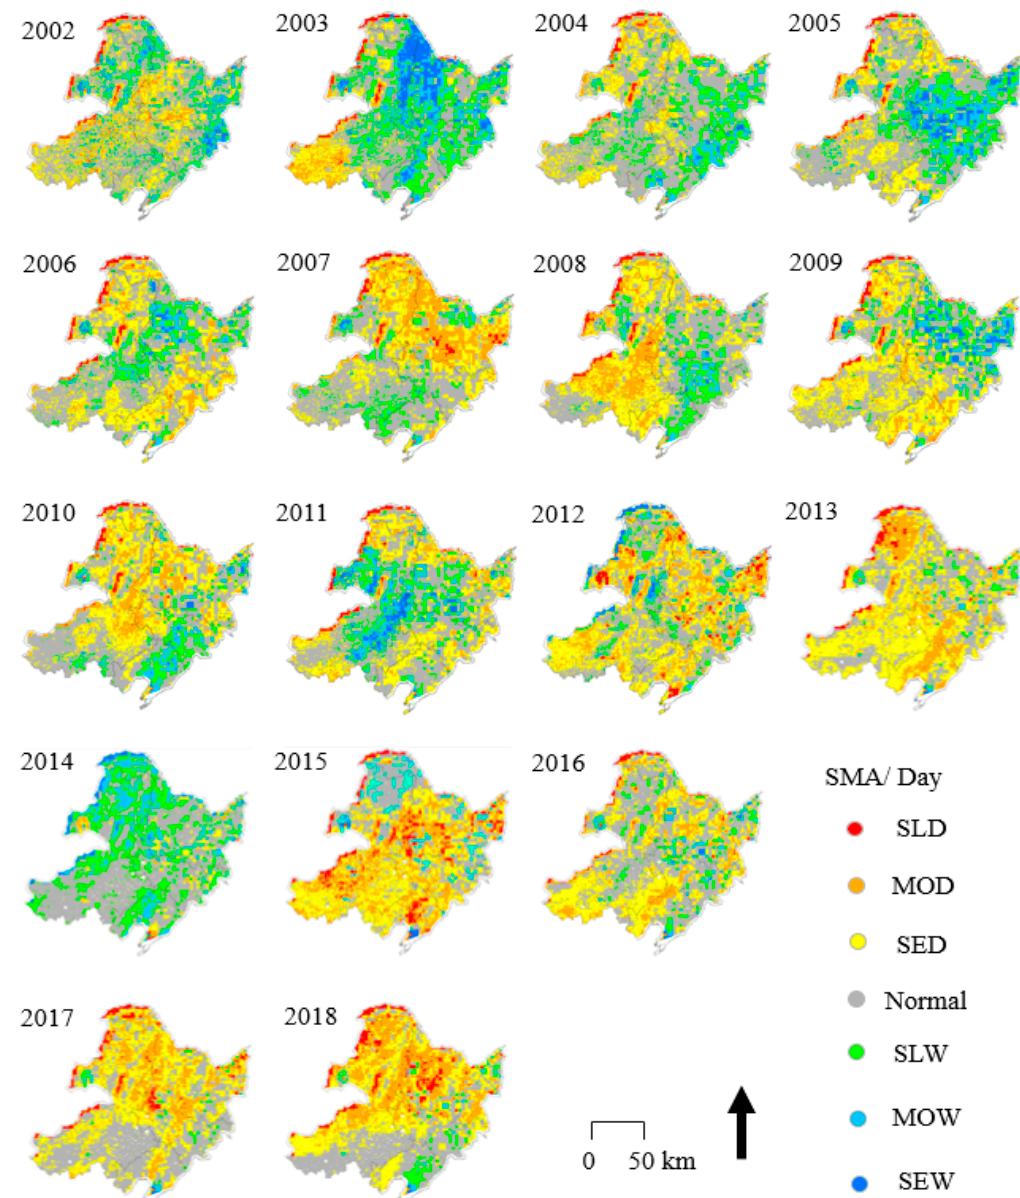
Figure 11. Spatial distribution of the nighttime SMA in NEC from 2002 to 2018.